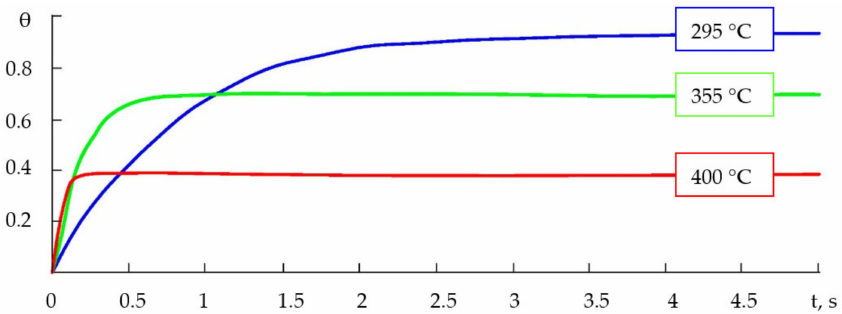
Figure 18. Typical dependencies of degree of filling on time (at different temperatures within BET